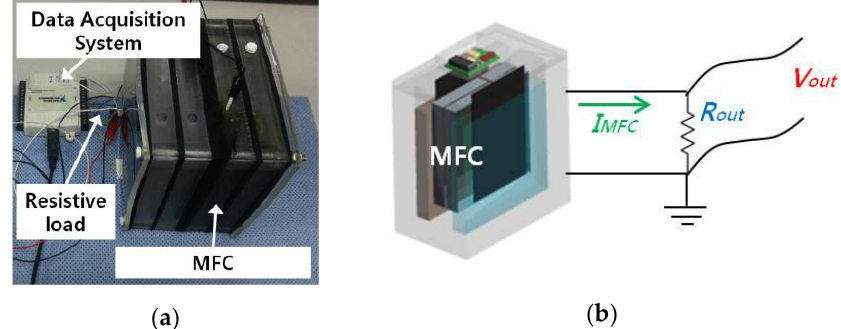
Figure 2. Experimental setup for characterizing the electricity generated by the MFC: ( a ) Measurement setup; ( b ) Schematic of circuit with varying resistive load.